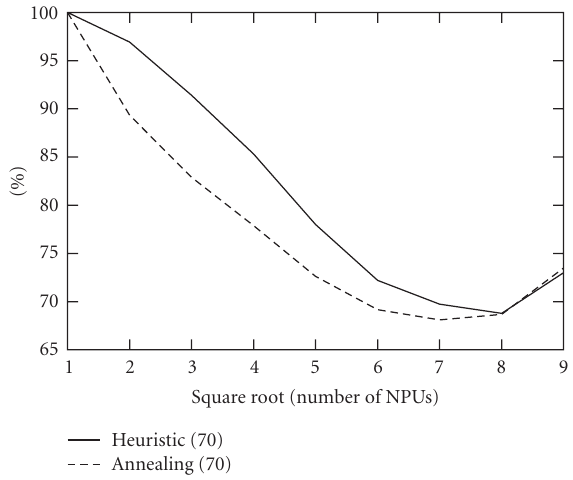
Figure 17: Relative quality of a fixed task count (70) and di ff erent array sizes.